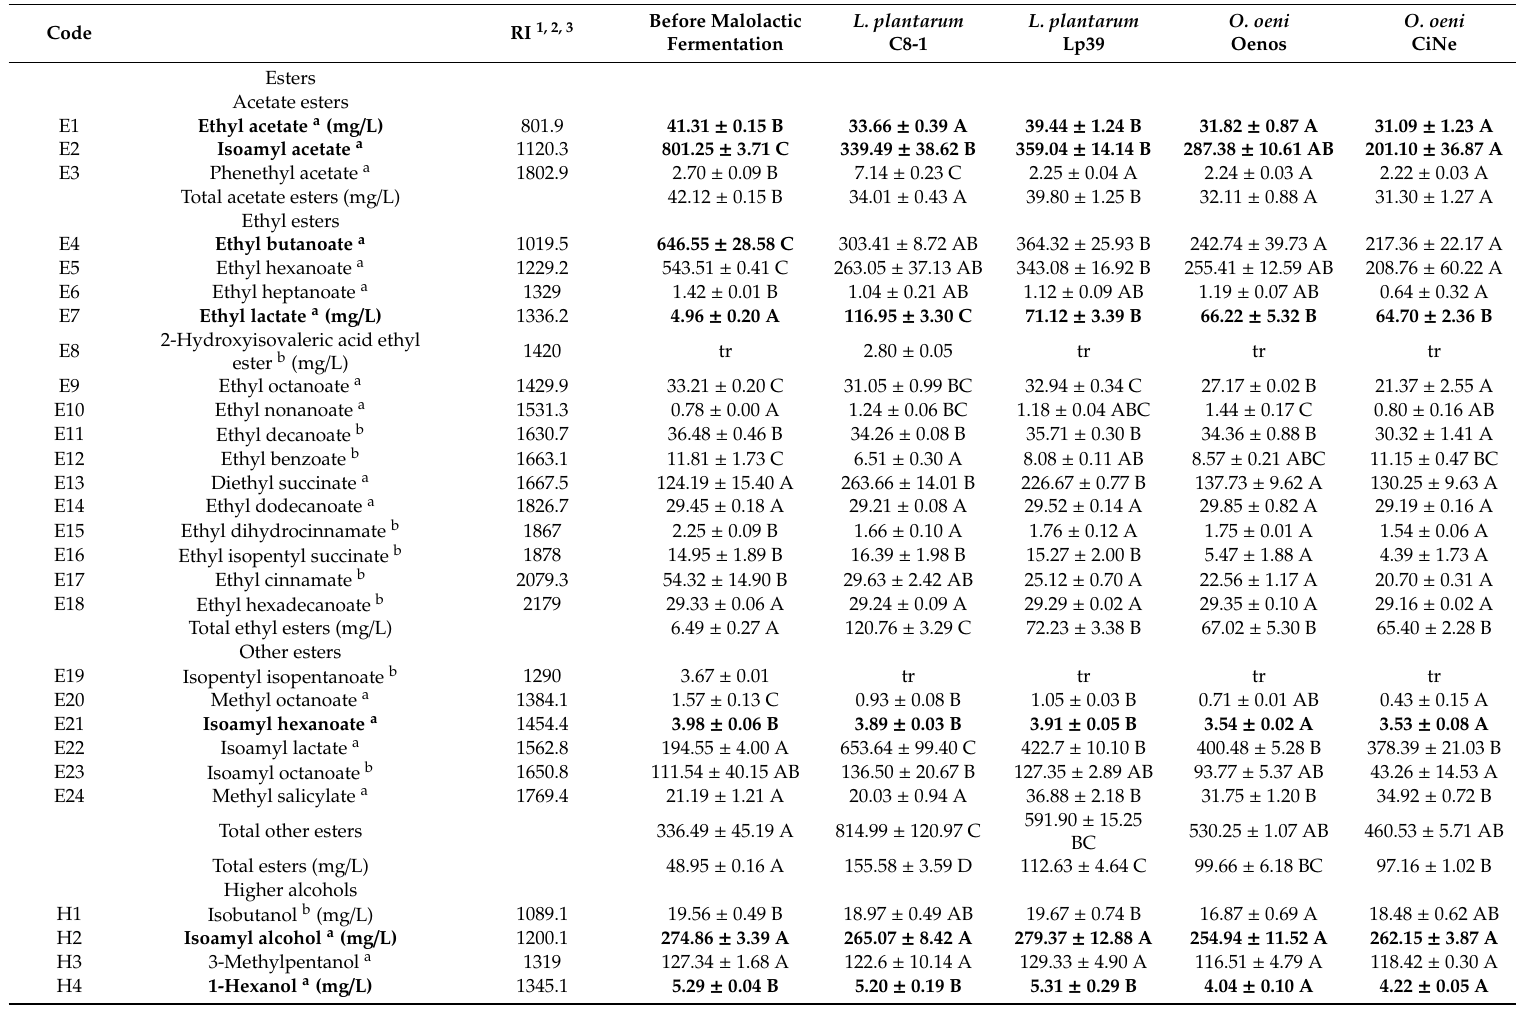
Table 3. Volatile compounds in Cabernet Gernischt wine before and after malolactic fermentation using L. plantarum (C8-1 and Lp39) and O. oeni (Oenos and